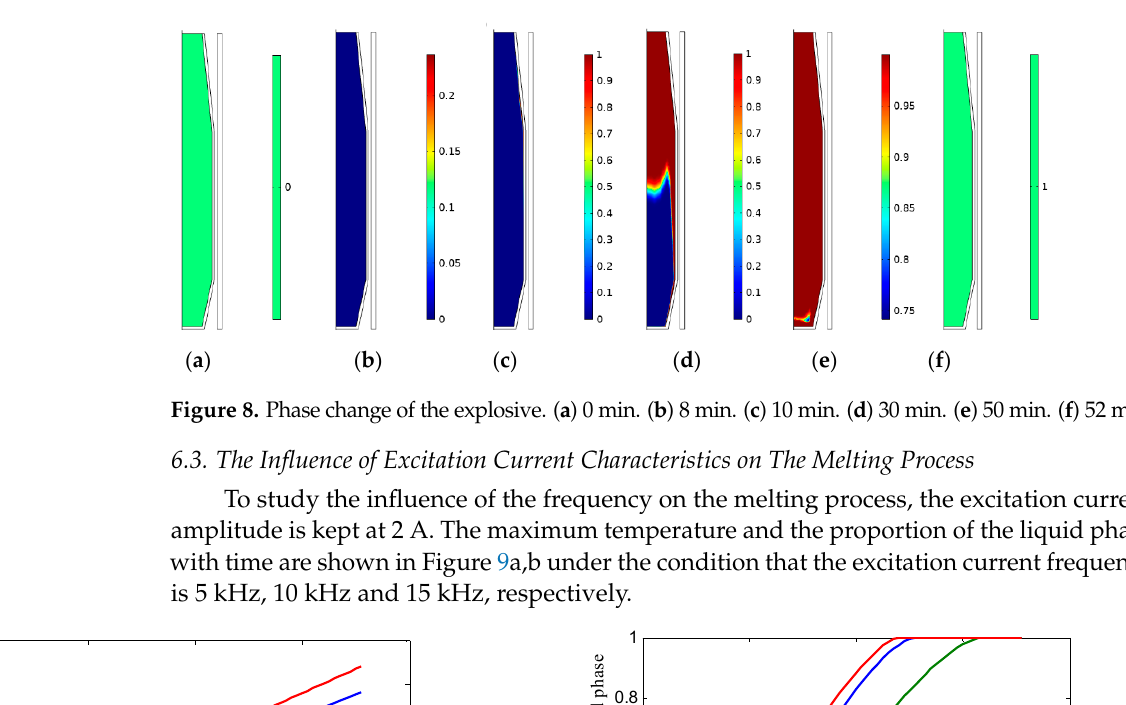
Figure 7. Temperature distribution of the explosive. ( a ) 0min. ( b ) 8min. ( c ) 10min. ( d ) 30min. ( e ) 50min. ( f ) 52min.